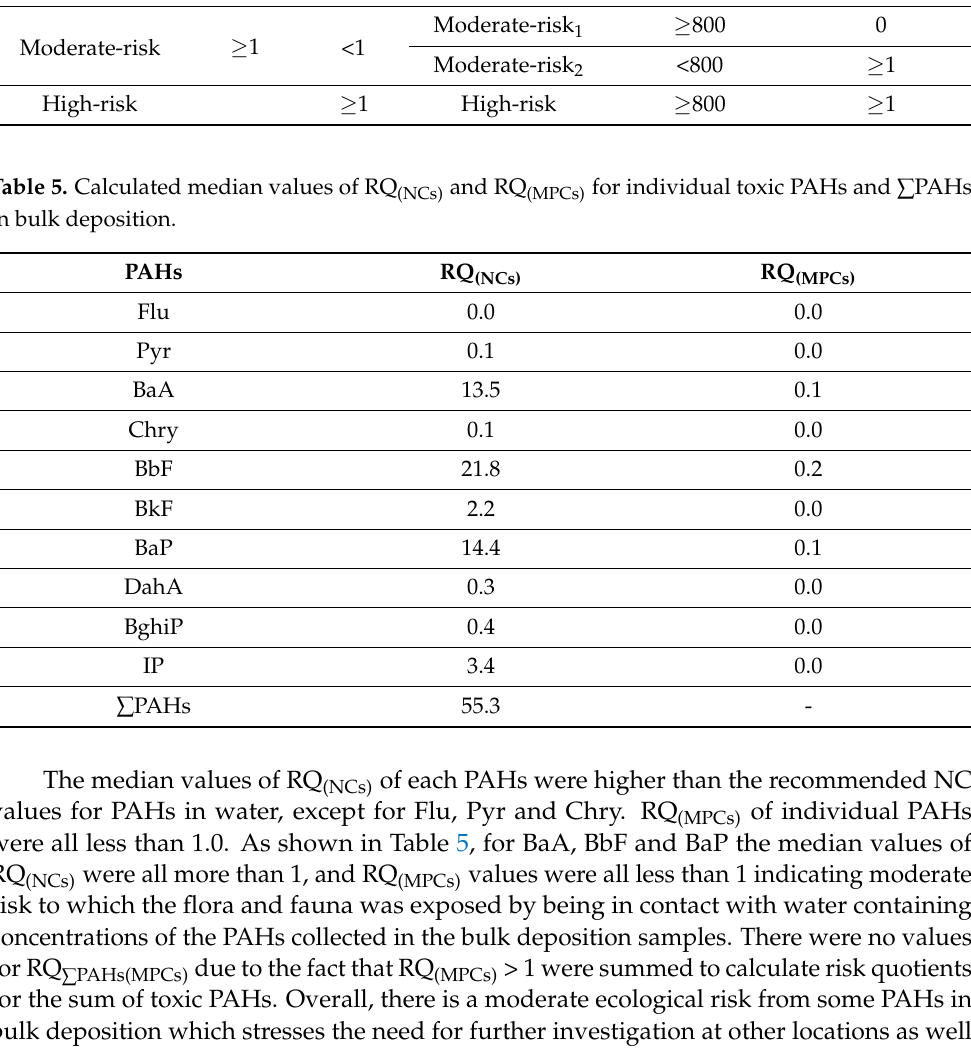
Table 4. Risk classification of individual PAHs and ∑ PAHs [64]. NCs and MPCs represented the neg- ligible concentrations and the maximum permissible concentrations of PAHs in water recommended by Kalf et al. (1997) [63] and Cao et al. (2010) [64]. Individual PAHs ∑ PAHs RQ NCs RQ MPCs RQ ∑ RQ ∑ PAHs(NCs) PAHs(MPCs) Risk-free 0 Risk-free 0 Low-risk ≥ 1; <800 0 Moderate-risk 1 ≥ 800 0 Moderate-risk ≥ 1 <1 Moderate-risk 2 <800 ≥ 1 High-risk ≥ 1 High-risk ≥ 800 ≥ 1